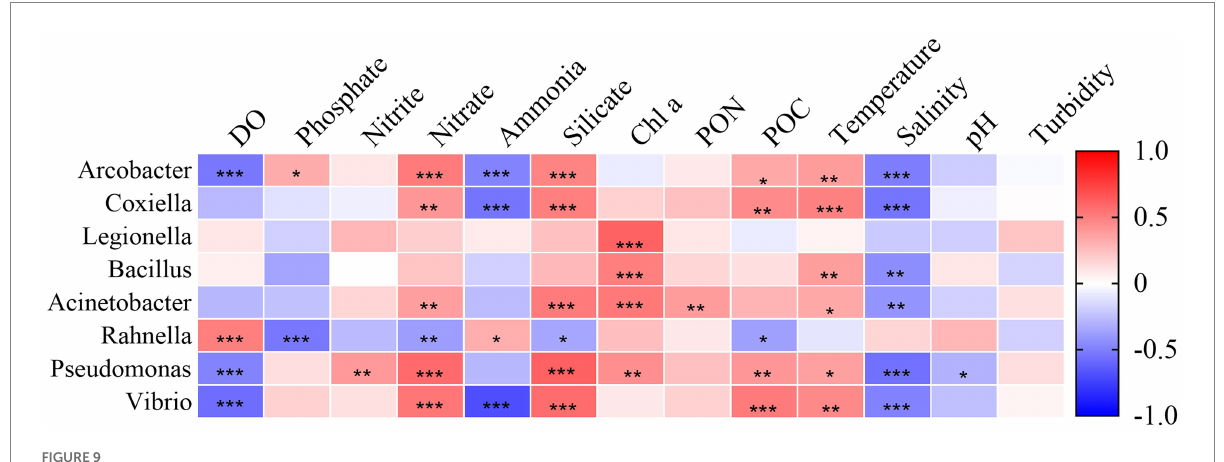
Tests were performed using all samples, and samples from different months, respectively. Correlations are shown in this table. Bold correlations were corrected by Benjamini-Hochberg multiple tests when the value of p was less than 0.05. The environment was calculated as the Euclidean distance of the physicochemical parameters.